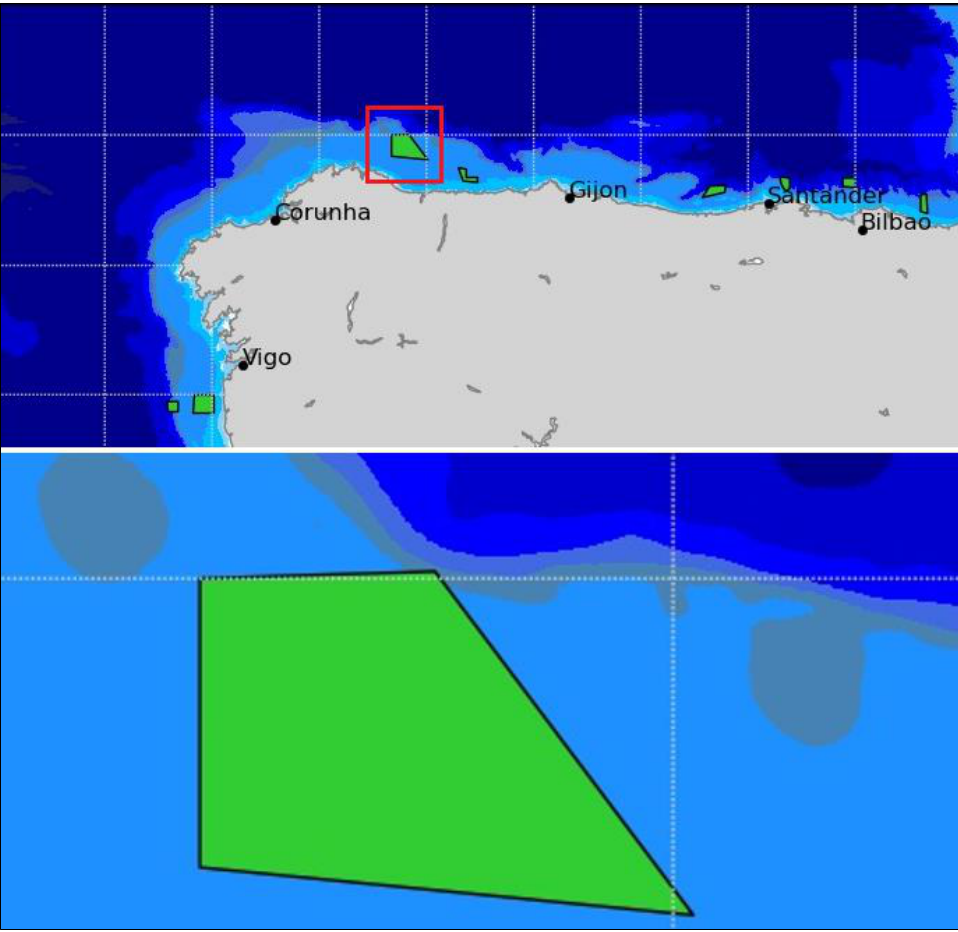
Figure 3. Example of a floating farm used in this study (Ribadeo offshore wind farm).